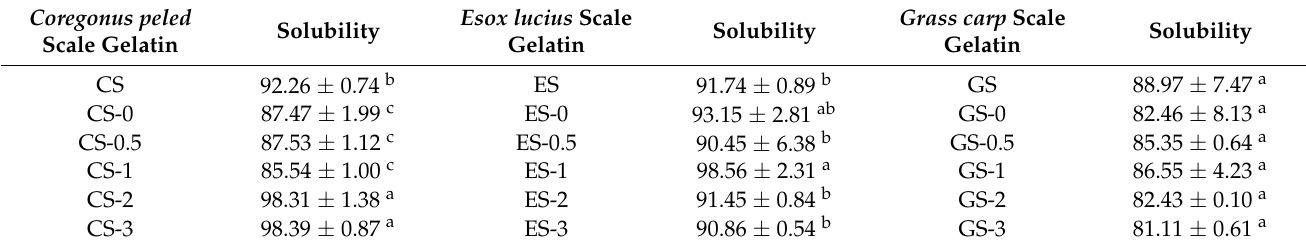
Table 2. The effect of phosphorylation on the solubility (%) of fish gelatin.